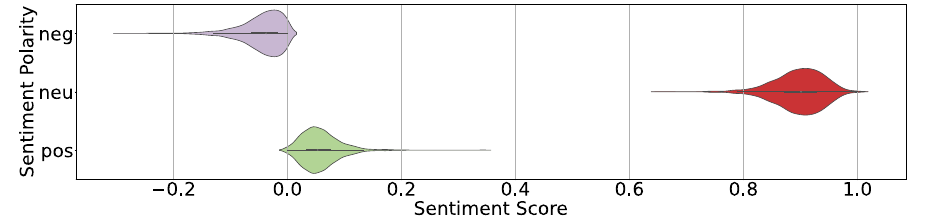
Fig 5. Illustrating the violin plot for distribution of sentiment scores across experimental dataset. The width of the plot at each instance shows the density estimate of articles having a polarity score. In addition to density and distribution, violin plot also shows the inter-quartile summaries of sentiment